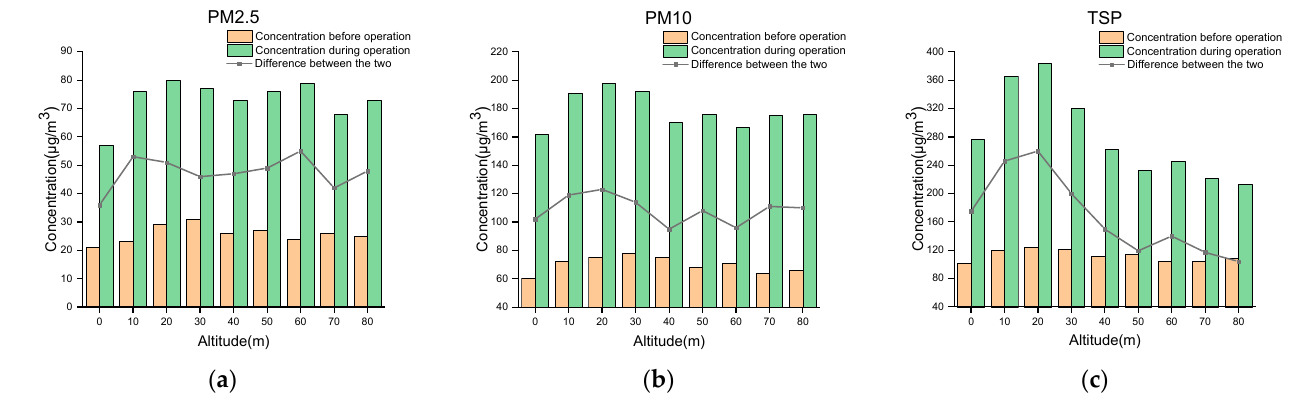
Figure 17. Comparison of PM concentration at measurement point before and after operation of harvester started working: ( a ) PM2.5; ( b ) PM10; ( c ) TSP.